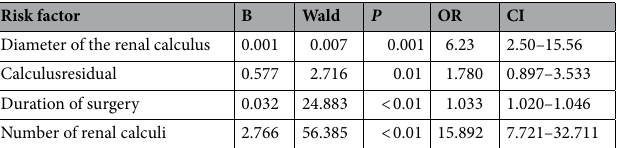
Risk factor B Wald P OR CI Diameter of the renal calculus